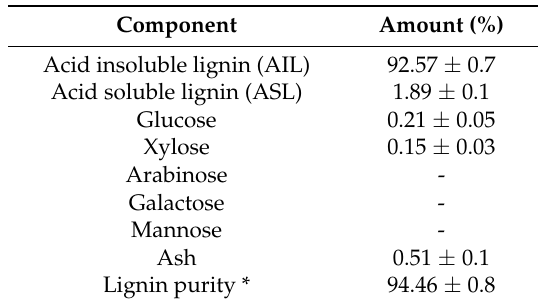
Table 2. Purity analysis of the lignin extracted from willow by ChCl-Lac (1:10) treatment at 120 °C for 12 h.